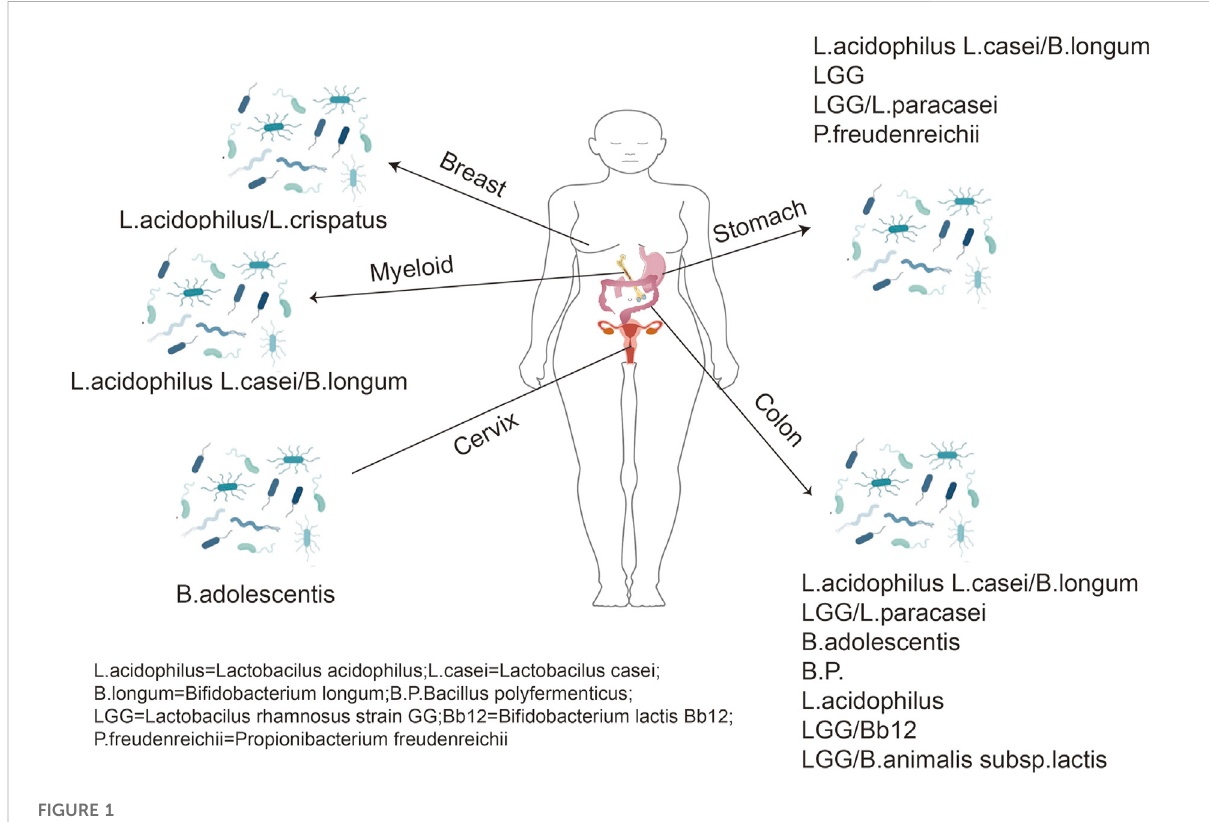
FIGURE 1 Proliferative effects of probiotics on human cancer